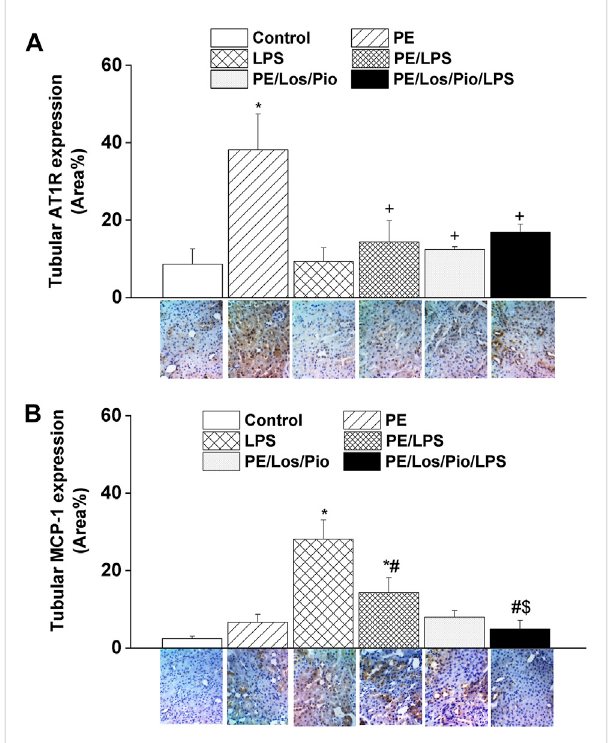
FIGURE 7 Effect ofcombined gestational losartan and pioglitazone therapy on immunohistochemical protein expressions of AT1 receptors (panel A ) and MCP-1 (panel B ) in renal tubular tissues of male offspring of PE or PE/LPS dams. The One-way ANOVA followed by the Tukey ’ s post hoc was utilized to measure statistical signi fi cance. Values are expressed as means ± S.E.M of 5 observations. * p < 0.05 vs. “ Control ” , # p < 0.05 vs. “ LPS ” , + p < 0.05 vs. “ PE ” , $ p < 0.05 vs. “ PE/LPS ” values. Representative images for immunostained renal tubular tissues are shown below bar